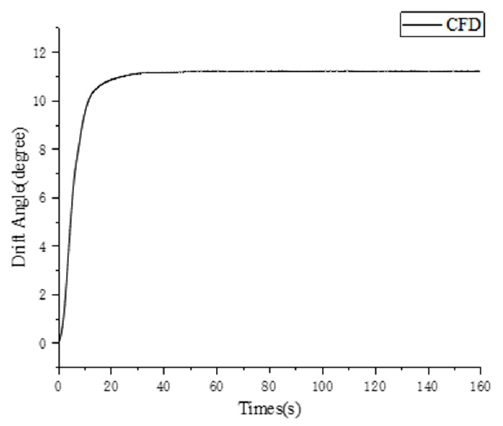
Figure 18. +35 ◦ drift angle in CFD simulation.